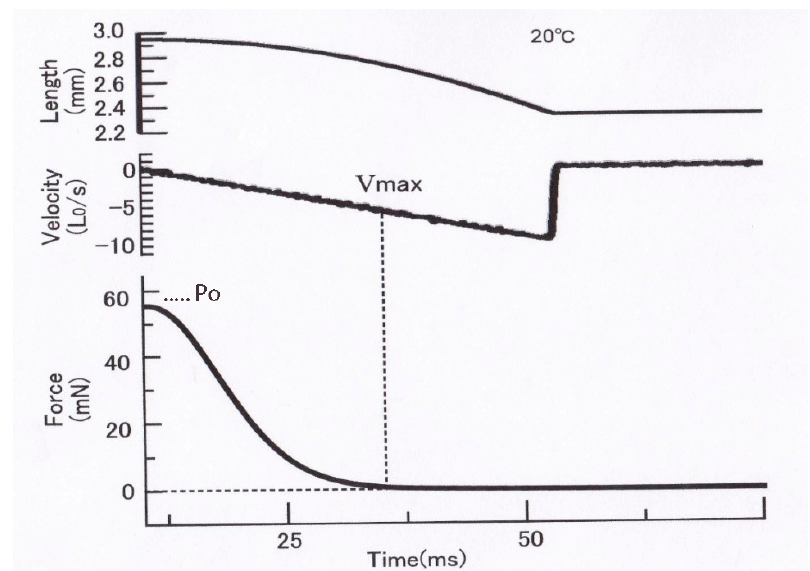
Figure 13. Recording of the whole range of P–V relation in one shot by applying a slow parabolic decrease in length of a single skinned muscle fiber, generating the maximum Ca 2+ -activated isometric force. (Upper record) Parabolic decrease in fiber length ( L ), L = -kt 2 . (Middle record) Linear velocity of fiber shortening ( V ), V = -dL / dt = -2k. (Lower record) Time course of the resulting decrease of force ( P ) in the fiber from Po to 0 along the vertical force axis. Note that V = 0 when P = Po, and V = Vmax